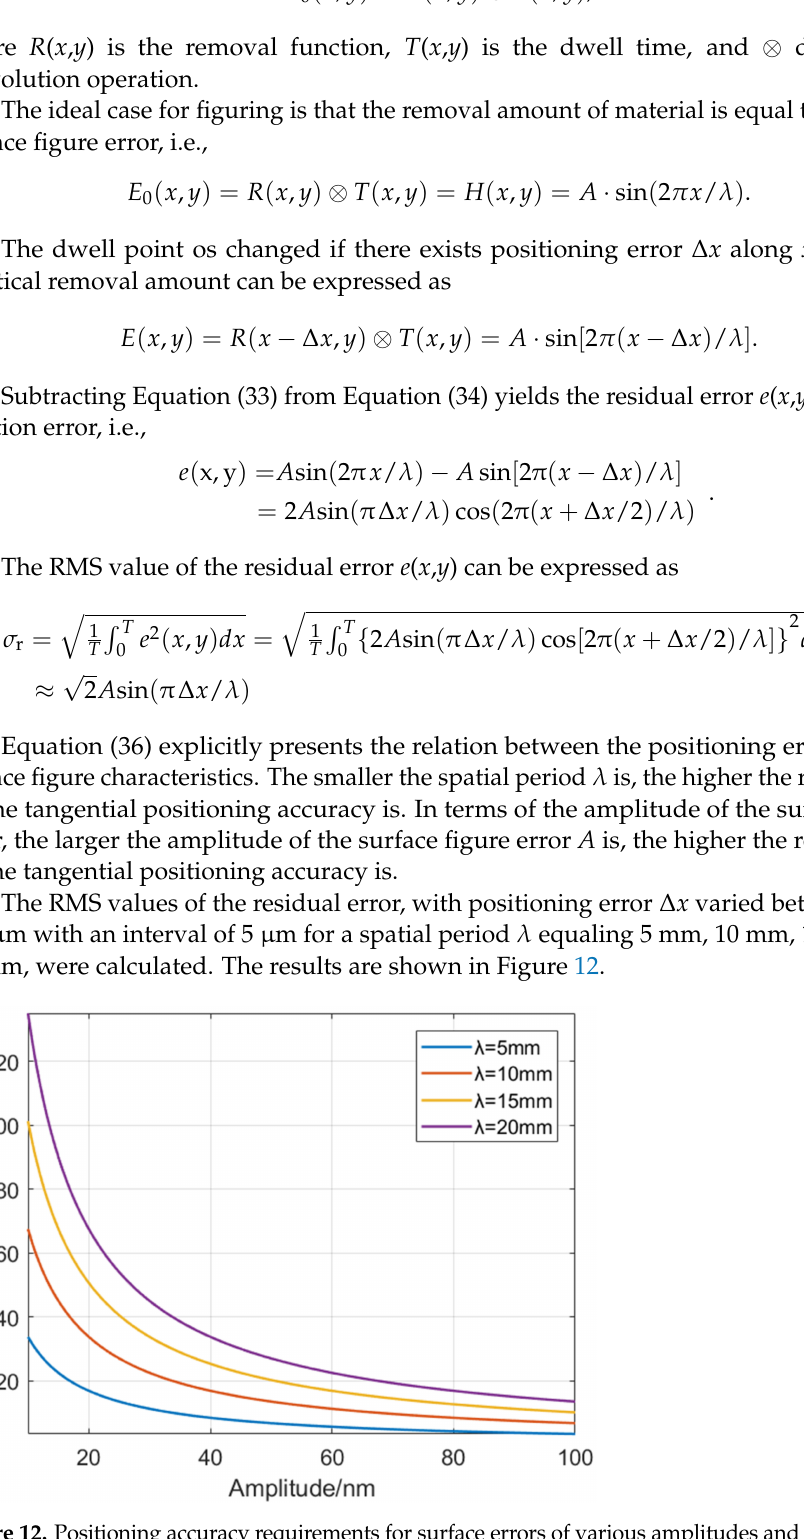
Figure 12. Positioning accuracy requirements for surface errors of various amplitudes and